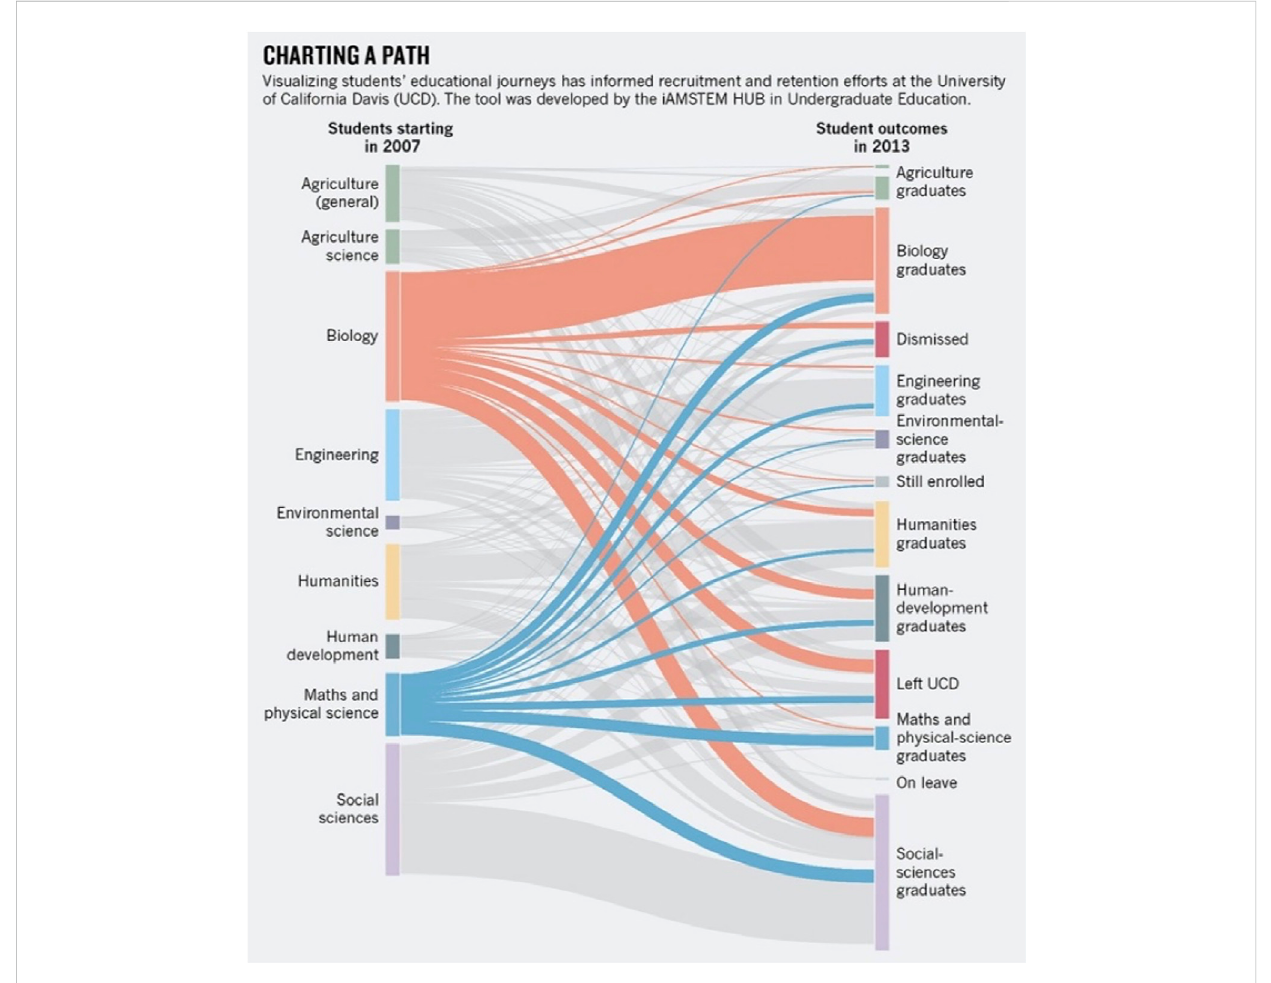
FIGURE 10 Results from a study of undergraduate degree outcomes versus incoming student interests, by fi eld. From Bradforth et al. (2015).